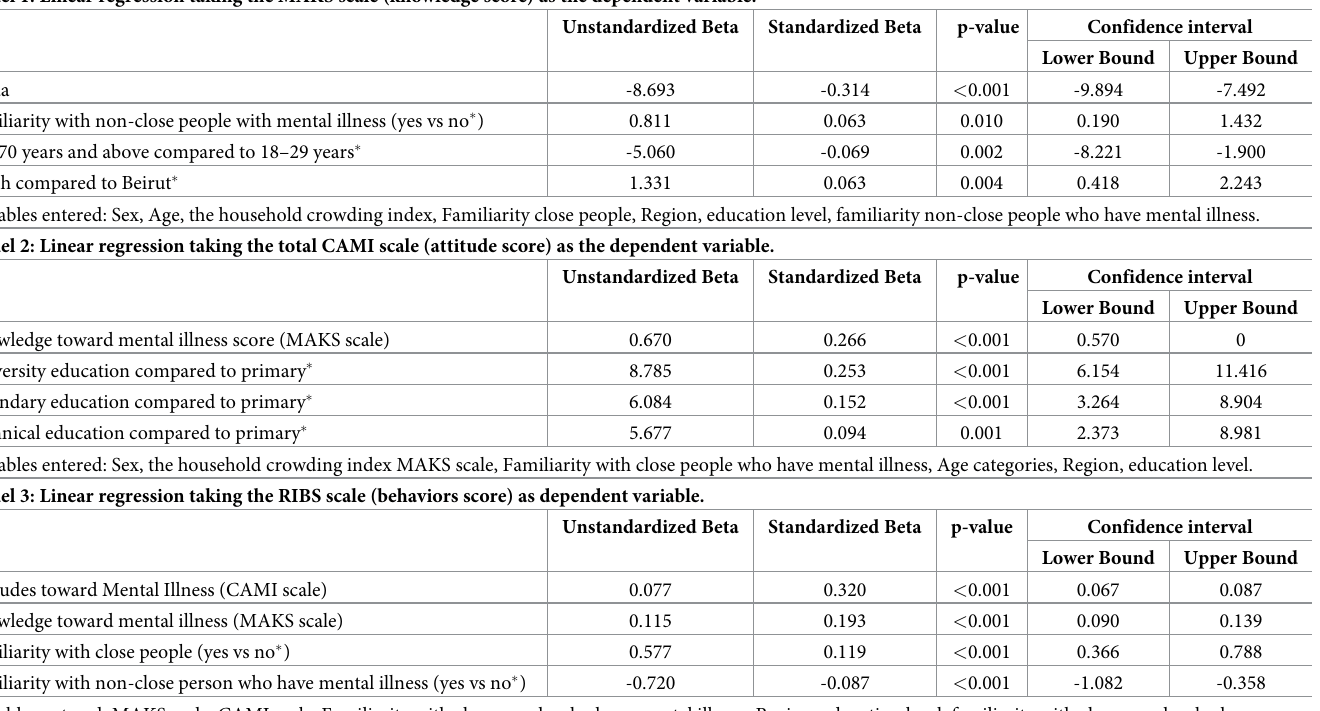
Table 4. Multivariable